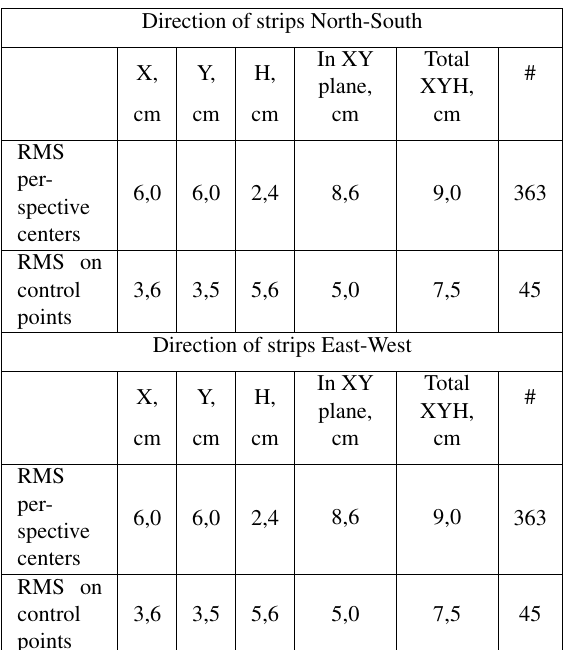
ciety of Photogrammetry, Fall Technical Meeting, Little